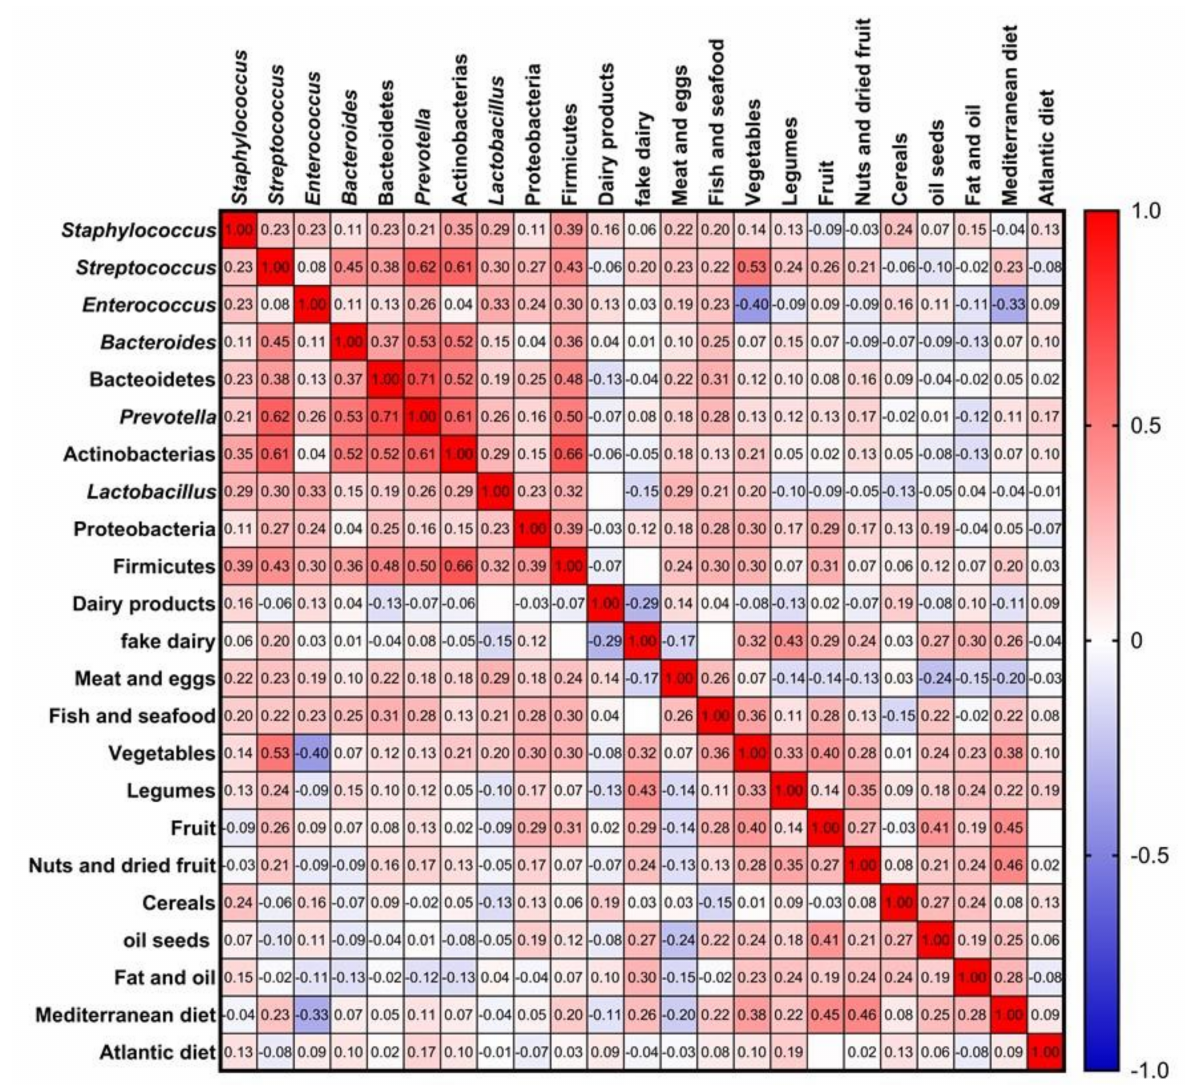
Figure 6. Graphical Spearman correlation matrix showing pairwise correlations between main food groups and microbiota in healthy Spanish mothers; colours are added for better visualization of correlation r